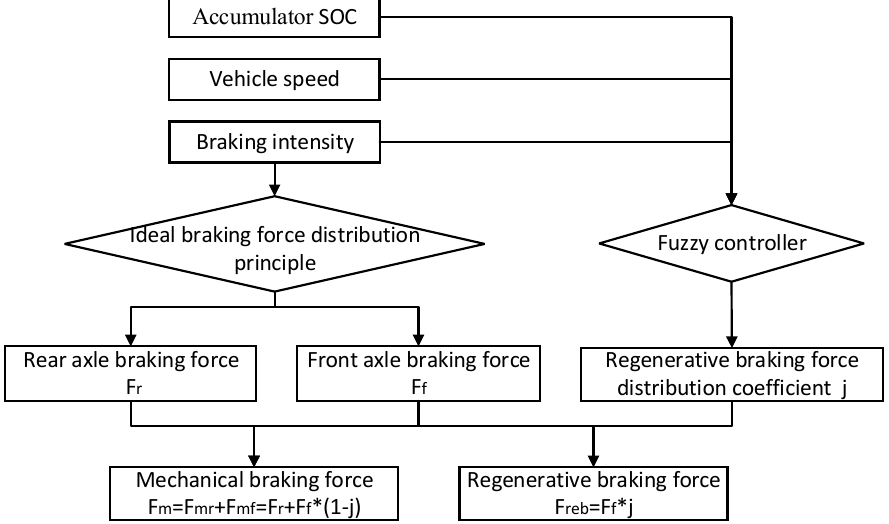
Figure 10. Braking-force distribution strategy.